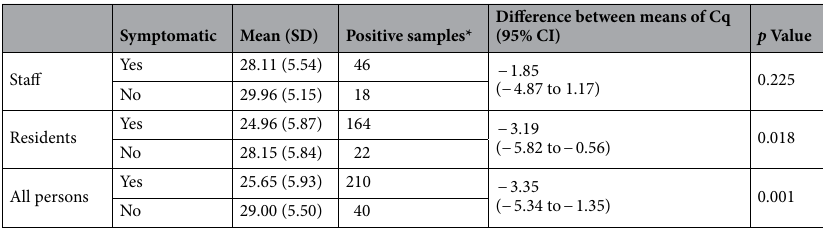
Table 5. Quantification cycle (Cq) values in symptomatic and asymptomatic infected staff and residents of long-term care facilities. *In 6 samples positive for GII norovirus, the Cq value could not be